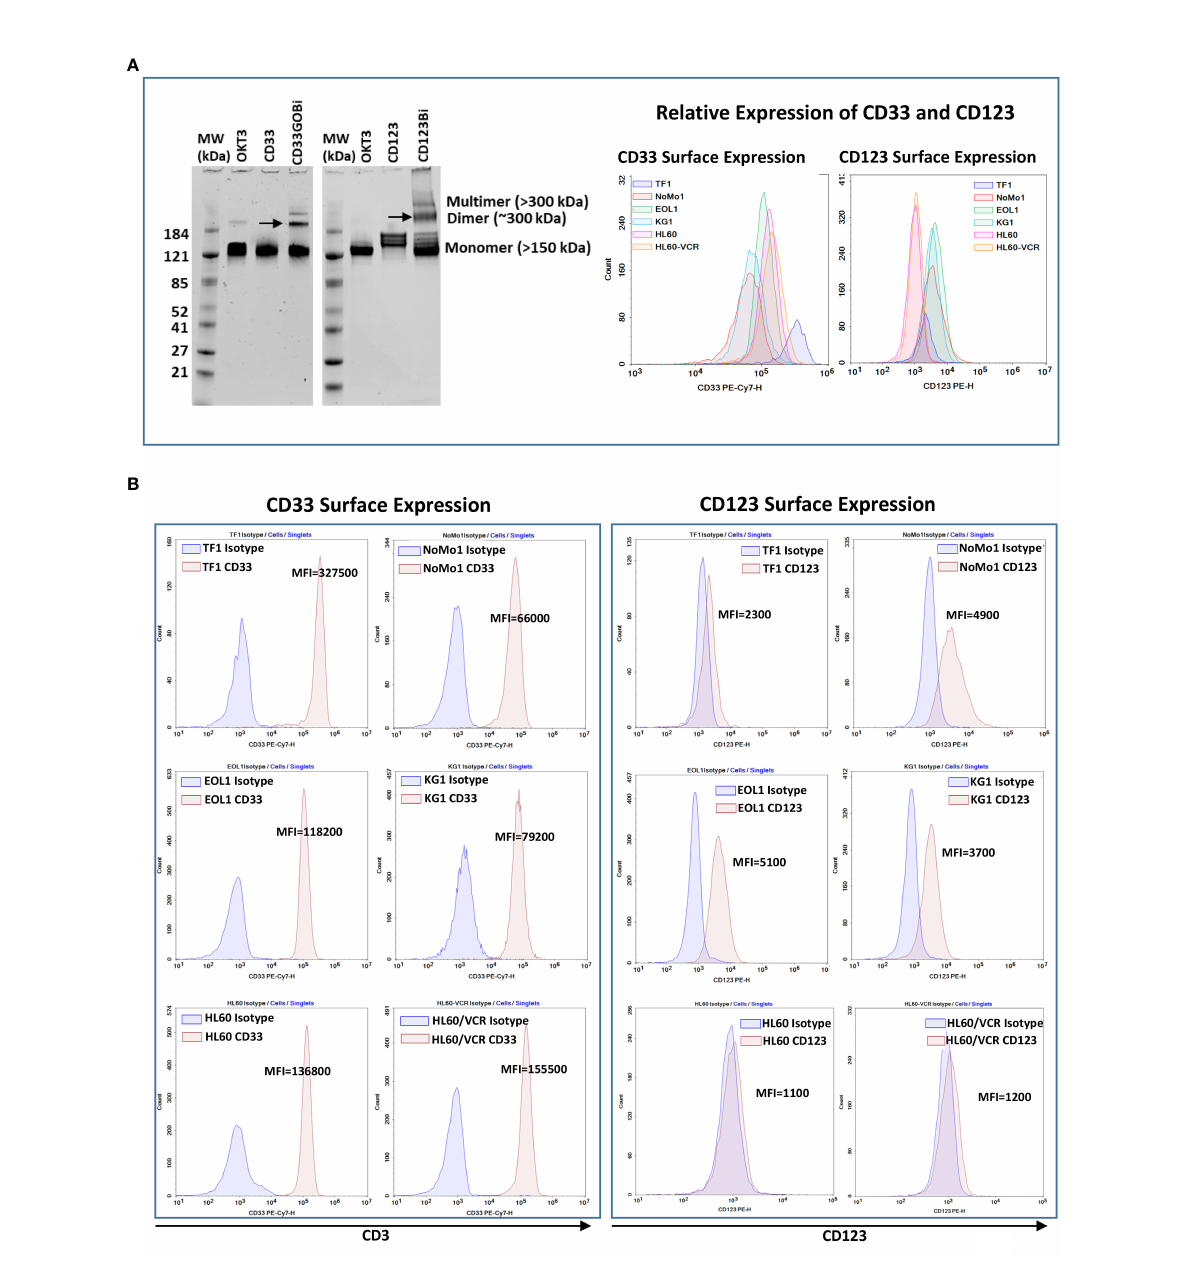
FIGURE 1 (A) Left panel showing SDS-PAGE images of heteroconjugated products of CD33GOBi and CD123Bi. Lane 1 in both gels: molecular weight markers (MW); Lane 2 in both gels: OKT3; Lane 3: CD33 in gel #1or CD123 in gel #2; Lane 4: CD33GOBi in gel #1 or CD123Bi in gel #2 containing unconjugated monomers, dimers (arrow), and multimers forms. Right panel shows the relative expression of CD33 and CD123 on AML cell lines. (B) Left panel shows surface expression of CD33 in TF1, NoMo1, EOL1, KG1, HL60 and vincristine resistant HL60 (HL60/VCR) AML cell lines. Right peak on each plot shows binding of anti-CD33 relative to isotype control mouse IgG1 (left peak). Right panel shows staining of anti-CD123 (right peak) relative to isotype control mouse IgG1 (left peak) in all six AML cell